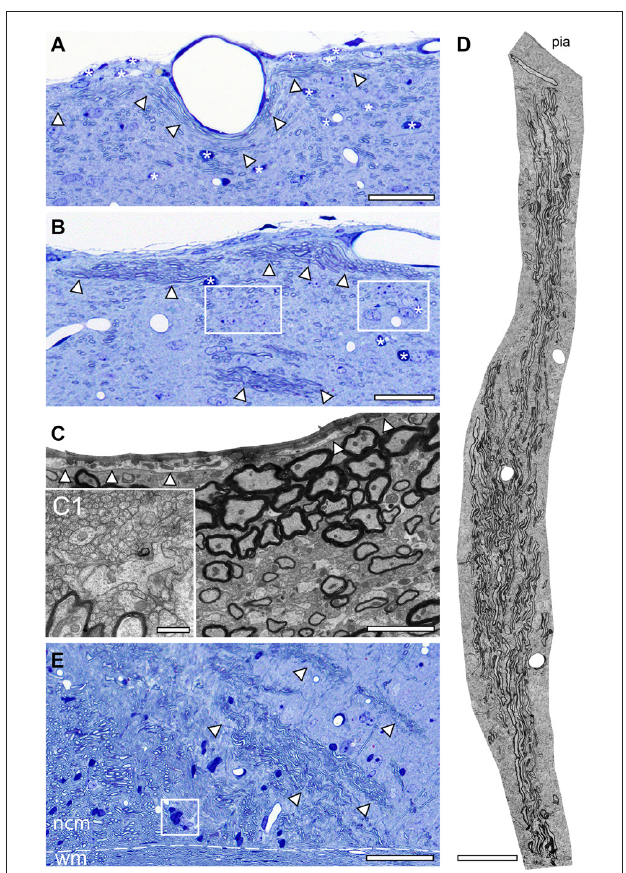
FIGURE 2 | Axonal fiber bundles in the adult reeler mouse neocortex. (A,B) Toluidine-blue stained semithin sections through the most superficial part directly underneath the pial surface of the adult reeler somatosensory neocortex. Note the long-range horizontal myelinated axons (arrowheads) running parallel to the pial surface and the scattered neurons some of which are organized in clusters (framed areas in B ). Some astro- and oligodendrocytes are marked by asterisks. Scale bar in (A,B) 100 µ m. (C) EM micrograph showing the density and distribution of myelinated and unmyelinated axons located close and running parallel to the pial surface. The basal lamina of the glia limitans is marked by arrowheads. Scale bar 2 µ m. (C1) Myelinated fibers are always accompanied by bundles of unmyelinated axons shown at higher magnification. Scale bar 0.5 µ m. (D) EM photomontage of a large axonal fiber bundle from the pial surface (pia) to deep neocortical mass. Note the packing density of the myelinated axons. Scale bar 200 µ m. (E) Toluidine-blue stained semithin section at the level of the white matter (wm)/neocortical mass (ncm) border (dashed line). Several fiber bundles (marked by arrowheads) arise from the white matter and ascend to different regions within the neocortical mass. Framed area shows a heterologous cluster of neurons and astrocytes. Scale bar 100 µ m.